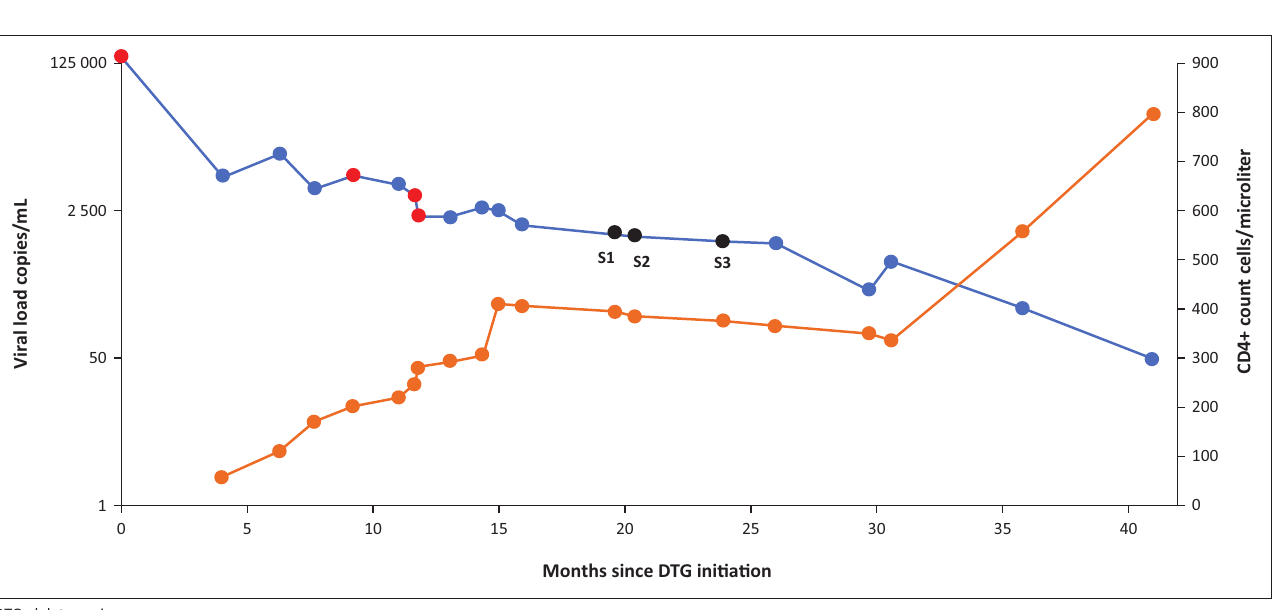
FIGURE 1: Patient viral load (blue) and CD4 data (orange) graph displayed in months since dolutegravir initiation indicating samples available for further investigation (black dots) (S1, S2 & S3). Routine drug resistance testing performed on multiple occasions are indicated by red